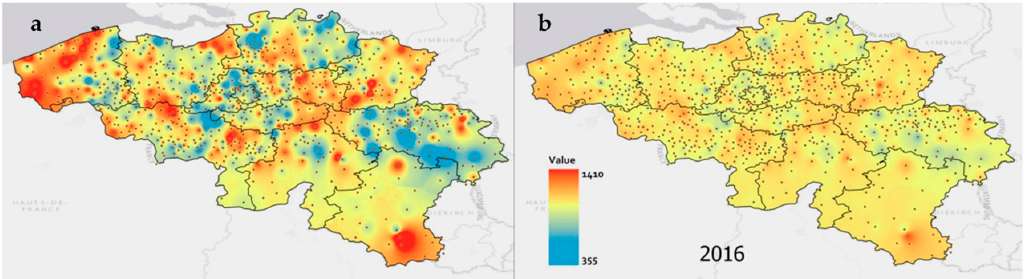
Figure 7. Annual specific yield variation from the installations (up to 20 kWp) for Belgium visualized using two different types of data stretching for 2016. Data stretching techniques ( a ) percent clip and ( b ) min-max used for data visualization.